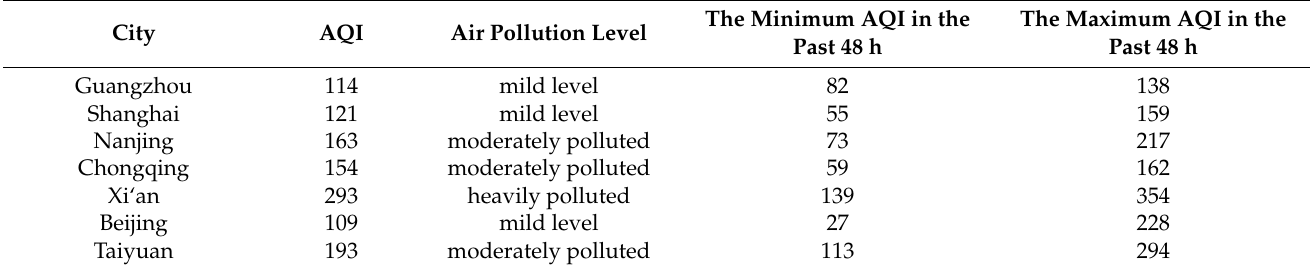
Table 1. Air pollution statistics in the 7